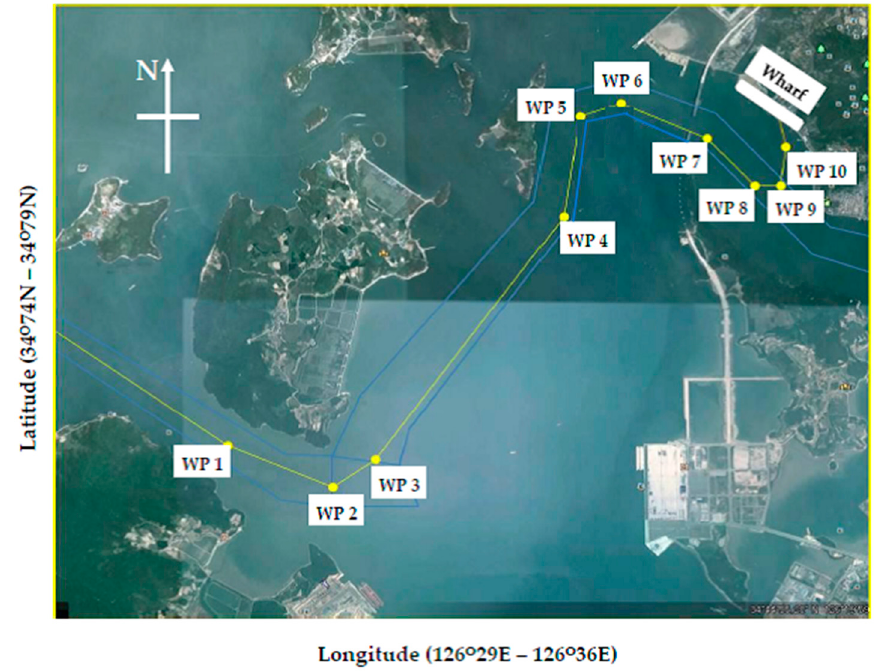
Figure 4 . The designed route of ship in fairway. Figure 4. The designed route of ship in